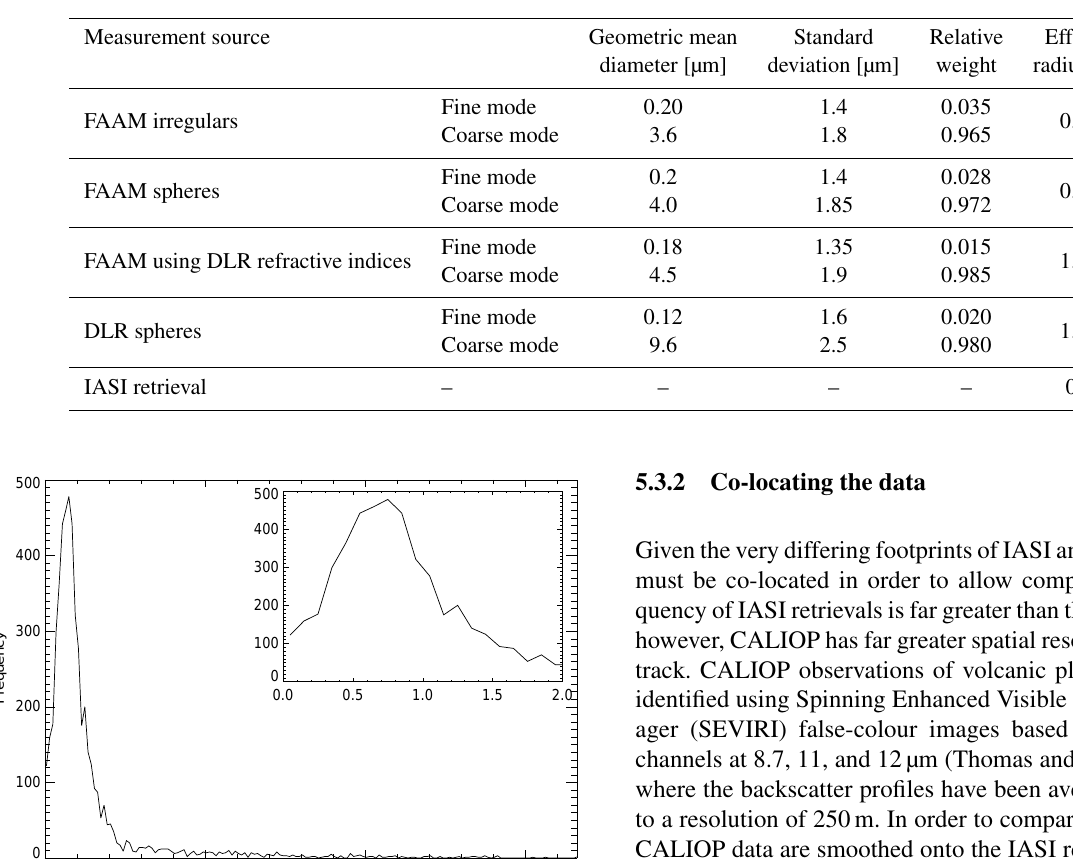
Table 1. The parameters observed by aircraft on 17 May 2010 (geometric mean diameter by volume, geometric standard deviation, and relative weight by mass, taken from Turnbull et al., 2012) and the effective radius calculated from the size distributions. The mode effective radius measured for the entire ash plume observed by IASI is also shown.